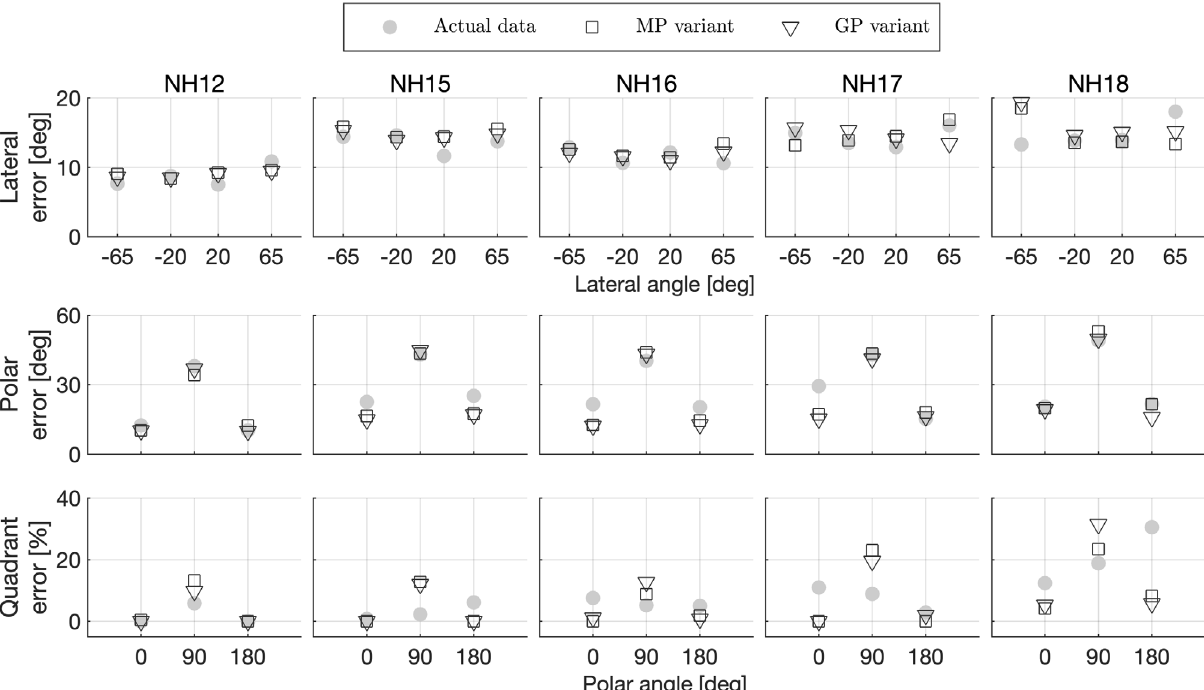
Figure 5. Sound-localization performance as function of the direction of a broadband sound source. Open symbols: Predictions obtained by the two model ’ s variants based on either spectral magnitude pro fi les (MPs) or gradient pro fi les (GPs). Filled grey symbol: Actual data from [23]. Top row: Lateral error, calculated for all targets with lateral angles of (cid:1) 65 (cid:1) ± 25 (cid:1) , (cid:1) 20 (cid:1) ± 20 (cid:1) , 20 (cid:1) ± 20 (cid:1) , and 65 (cid:1) ± 25 (cid:1) . Center and bottom rows: Polar error and quadrant error rates, respectively, calculated for all median-plane (±30 (cid:1) ) targets with polar angles of 0 (cid:1) ± 30 (cid:1) , 90 (cid:1) ± 60 (cid:1) , and 180 (cid:1) ± 30 (cid:1)